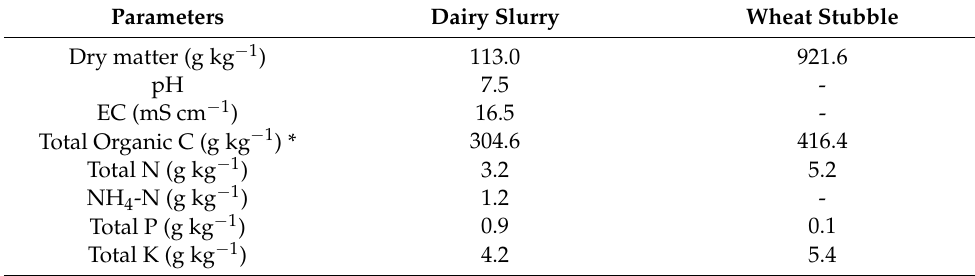
Table 5. Main characteristics of the dairy slurry and wheat stubble (Mean, n =